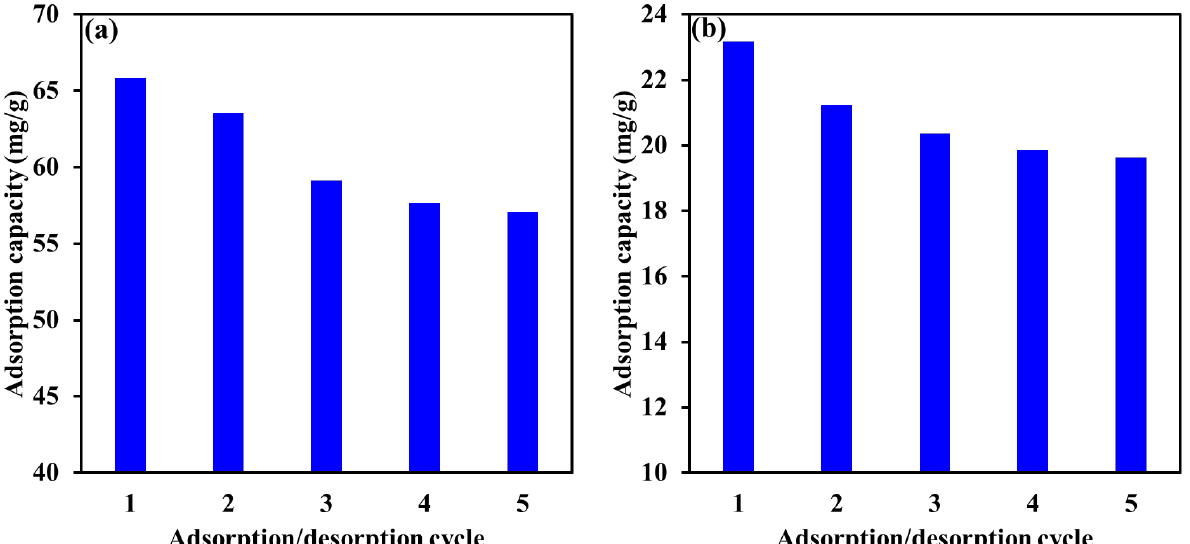
Figure 15. Reusability performance of Mg-Ca-Al-LDO for the adsorptive removal of EBT ( a ) and Cr ( b ) for five consecutive adsorption/desorption